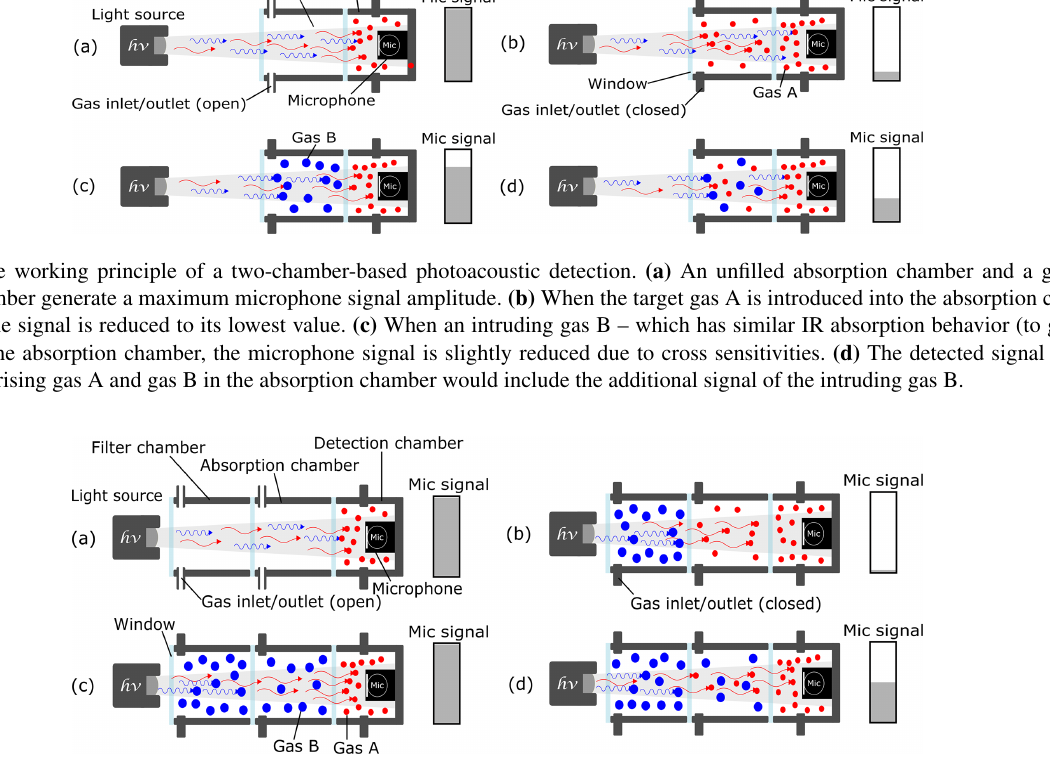
Figure 2. The working principle of a three-chamber-based photoacoustic detection. (a) An unfilled absorption and filter chamber and a gas-filled detection chamber generate the maximum microphone signal amplitude. (b) The intruding gas B is filled into the filter chamber and absorbs all of the “blue” photons. When the target gas A is introduced into the absorption chamber, the microphone signal is reduced to its lowest value. (c) When gas B – which has similar IR absorption behavior (to gas A) – is filled into the absorption chamber, the microphone signal stays at its maximum value due to the eliminated cross sensitivities. (d) The microphone signal only depends on the concentration of gas A in the absorption chamber regardless of the amount of the intruding gas B.